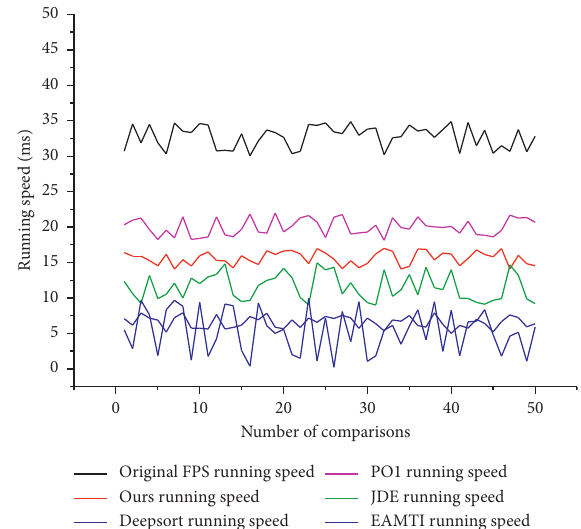
Figure 5: Running speed comparison results.